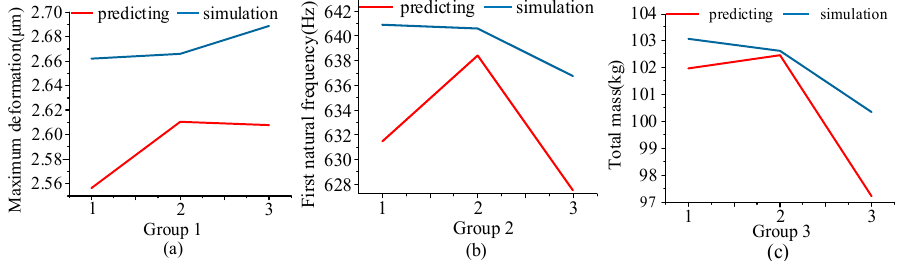
Figure 32. Prediction and simulation values: ( a ) deformation; ( b ) first natural frequency; ( c ) total